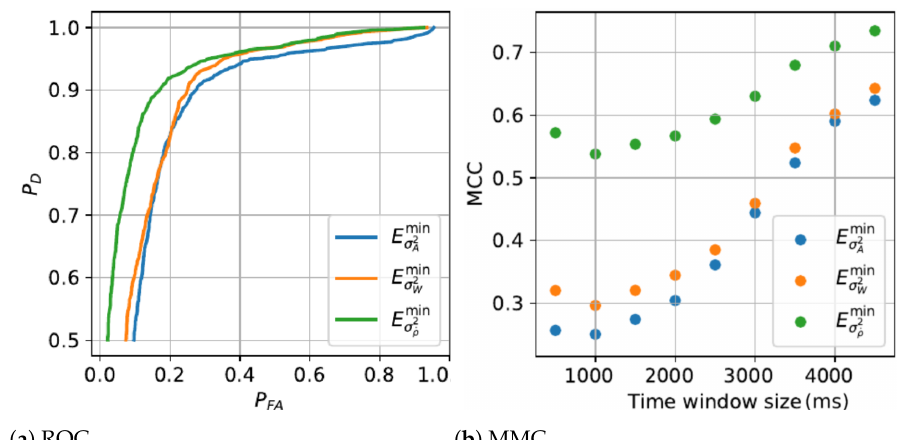
Figure 4. Immobility features